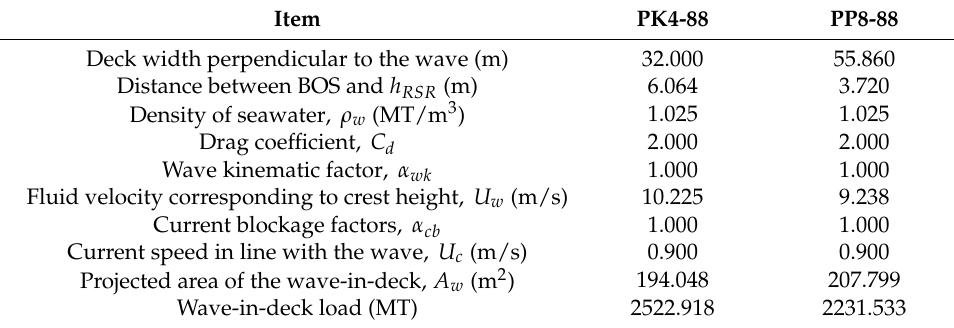
Table 3. Wave-in-deck load calculation.